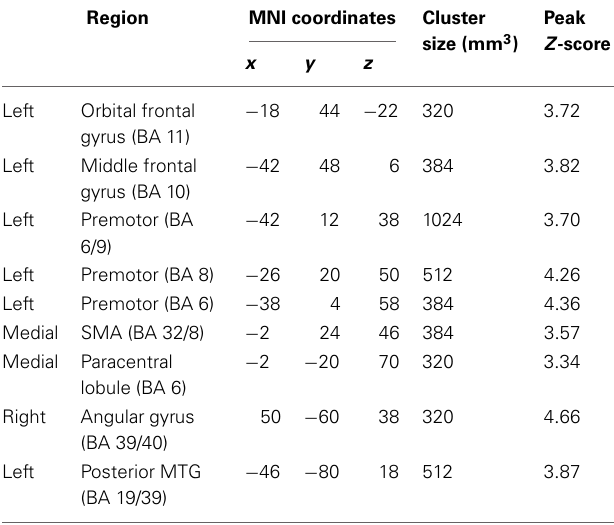
Table 2 | Regions showing Group (ASD, Control) × State (Resting, Sustained attention task) interaction for distant functional